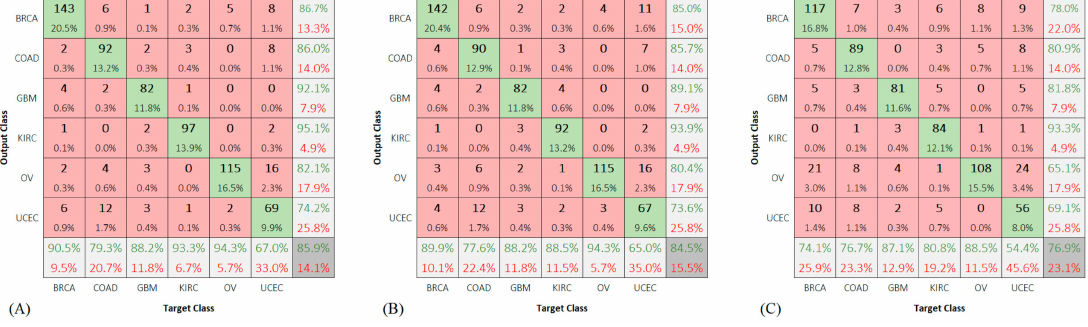
Figure 7. Confusion matrix for running: ( A ) CNN6, ( B ) ResCNN6, and ( C ) VGG16, on the test group.